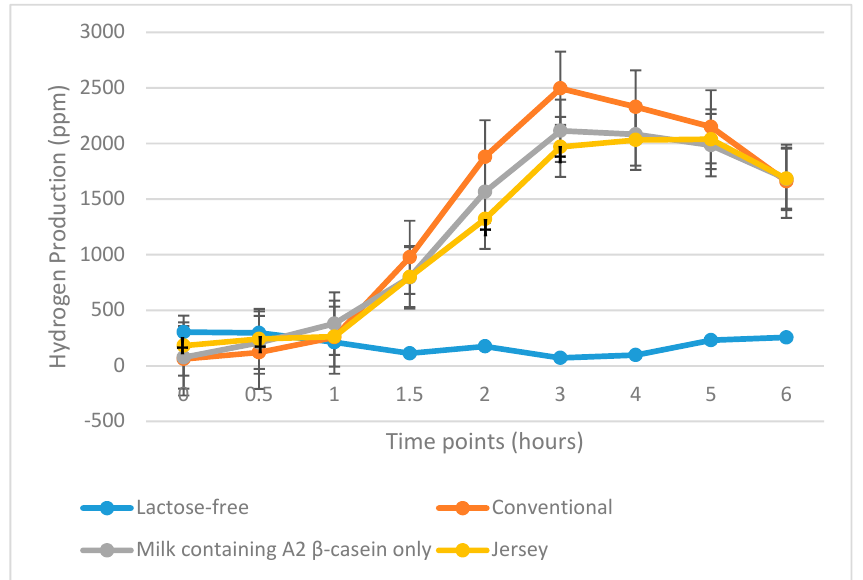
Figure 4. Total hydrogen produced during the 6 h after consuming the four milk products in 25 lactose intolerant subjects. ppm, parts per million. † p = 0.05, † p = 0.03, † p = 0.01, and † p = 0.05 for Jersey milk vs. commercial milk at 0, 0.5, 2, and 3 h, respectively.